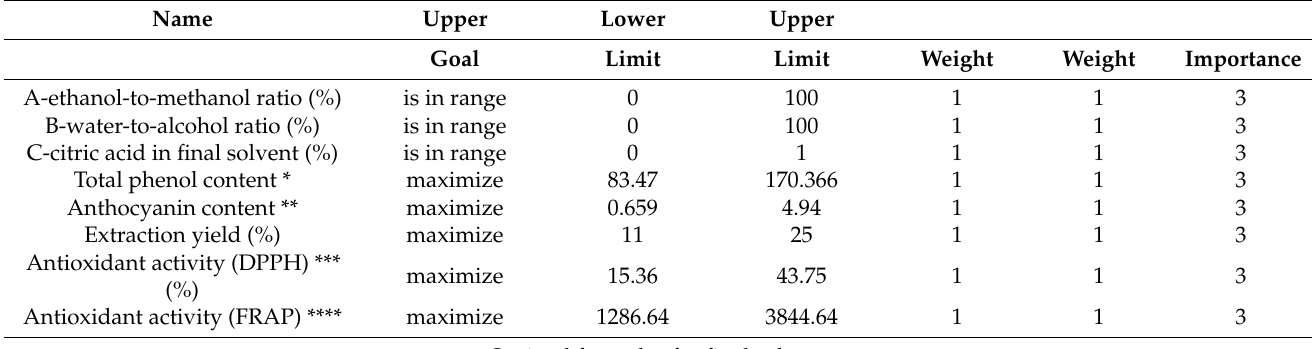
Table 7. The limitations utilized for optimization of bioactive compound extraction of eggplant peel by the different solvent combinations, and the optimal formula and data validation (actual and predicted) for total phenol content, anthocyanin content, extraction yield, and antioxidant activity